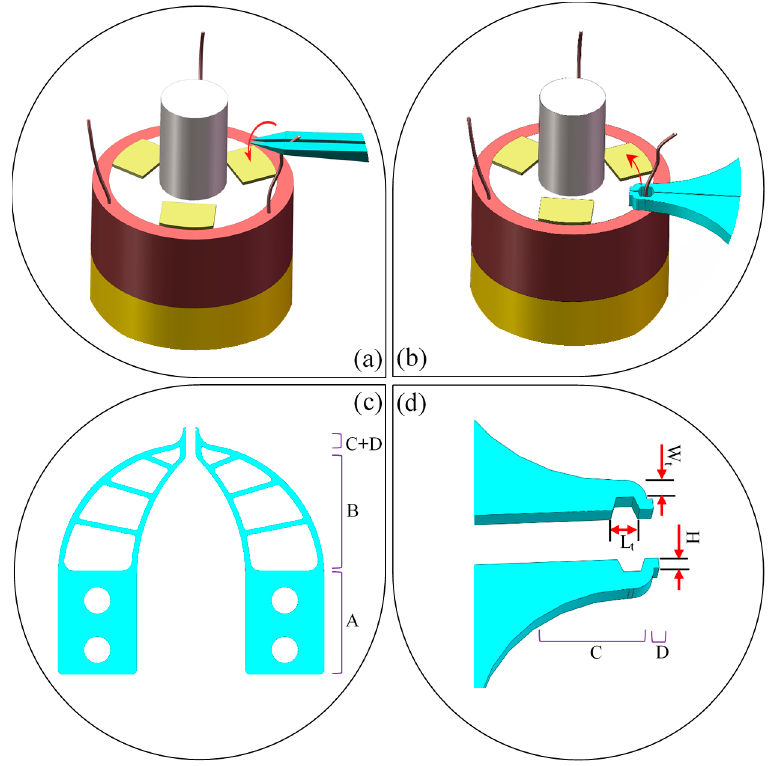
Figure 4. Design of clamping strategy for thin electrode wires: ( a ) Direct clamping strategy and tip of its corresponding micro-gripper; ( b ) Enveloping strategy and its corresponding micro-gripper, where ‘A’ is called the assembly region, ‘B’ is called the elastic-beam region, ‘C’ is called the tip-enveloped region, ‘D’ is called tip-protected region; ( c ) Model of enveloping-type micro-gripper’s tip; ( d ) The enveloped local micro-gripper’s tip containing the regions C and D.